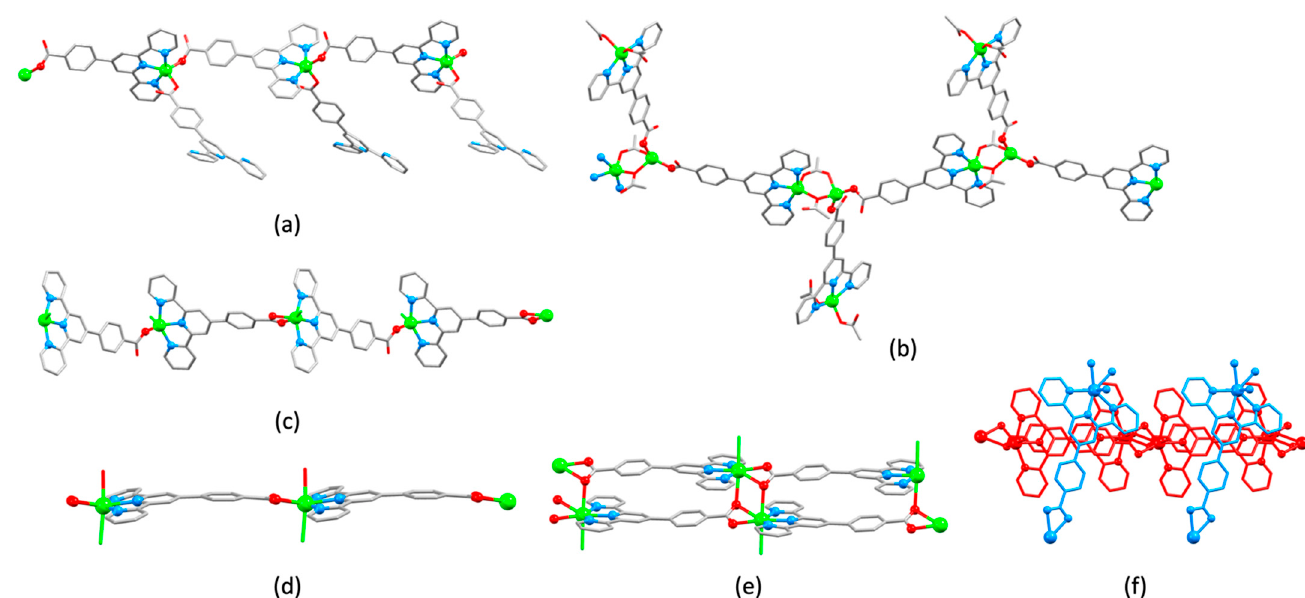
Figure 5. Parts of the 1D-coordination polymer chains in ( a ) [Zn( 4 ) 2 ] n · 0.5 n H 2 O (CSD refcode CEJBAW), ( b ) [{Zn 2 ( µ - OAc) 2 }Zn(OAc) 2 ( 4 ) 2 ] n · n H 2 O (recode DUBWUV), and ( c ) [Zn 2 Cl 2 ( 4 ) 2 ] n · 0.5 n H 2 O (refcode GEYSOU). The structure of [ZnCl( 4 )] n · [ZnCl(OH 2 )( 4 )] n (refcode NUCBAR) contains both ( d ) single [ZnCl(OH 2 )( 4 )] n 1D-polymers, and ( e ) double- stranded [ZnCl( 4 )] n polymers; ( f ) π -stacking within the double-stranded chain (red) and between the two different chains (red and blue) is the dominant packing interaction in [ZnCl( 4 )] n . [ZnCl(OH 2 )( 4 )] n .